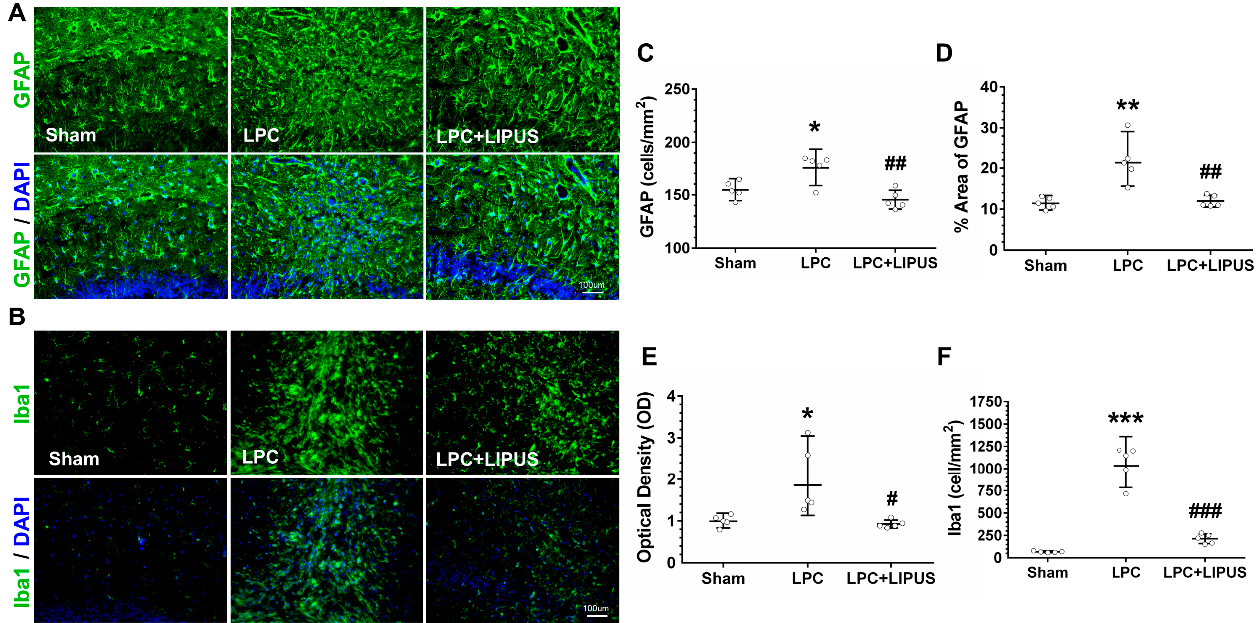
Figure 2. LIPUS treatment reduced astrocytic activation and microglial cell density in the vicinity of the demyelination lesion. Immunofluorescent staining image of the astrocytic marker GFAP ( A ) and the microglial marker Iba1 ( B ). ( C ) LIPUS decreased the density of the astrocytic marker GFAP. LIPUS significantly decreased the percentage area covered by GFAP ( D ) and reduced the GFAP optical density ( E ) in the vicinity of the demyelinated area of the hippocampus in LPC-treated rats. ( F ) The LIPUS group showed a significantly reduced density of Iba1 + cells in the vicinity of the demyelination lesion compared to the LPC group. * and # denote significant differences from the sham and LPC groups, respectively (*, p <0.05; **, p < 0.01; ***, p < 0.001; # , p < 0.05; ## , p < 0.01; ### , p < 0.001, n = 5). Scale bar = 100 μ m. LPC: lysolecithin, LIPUS: low-intensity pulsed ultrasound, GFAP, glial fibrillary acidic protein, and Iba1: ionized calcium-binding adaptor molecule